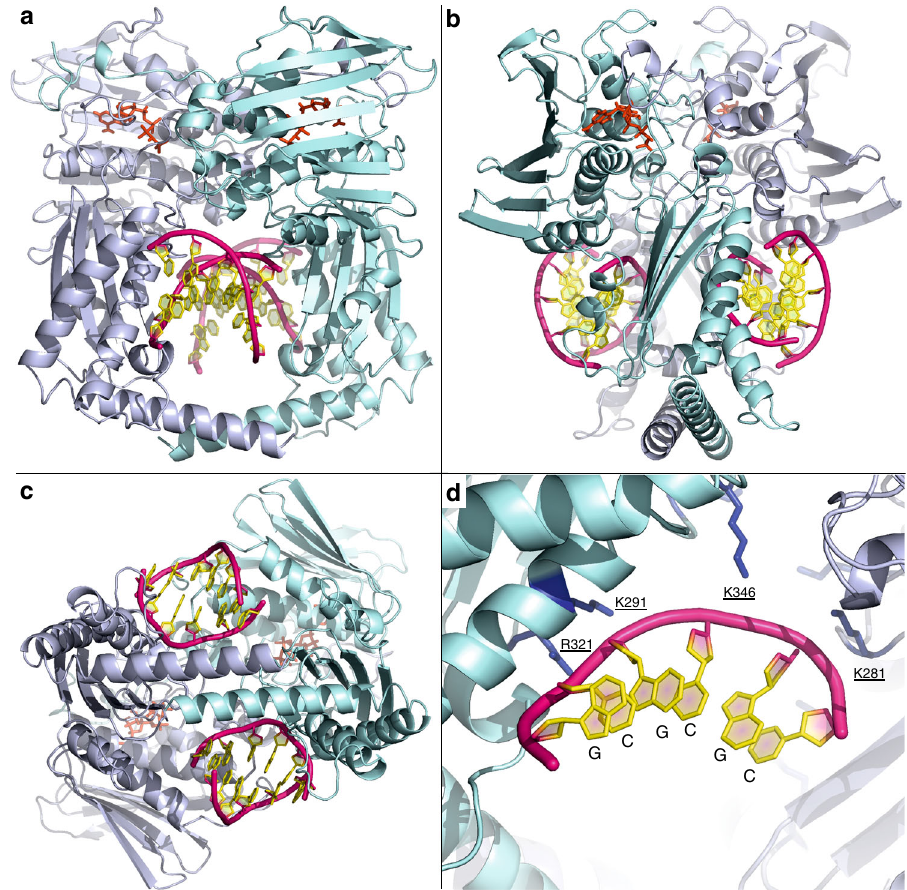
Fig. 3 X-ray crystal structure of ParE44 with side-bound 5 ′ -GCGCGC-3 ′ duplex DNA and AMP-PNP. a , b , c Front, side and bottom views of the complex and d residues that interact with the DNA and were targeted for mutagenesis (underscored). The ParE44 protein forms a closed dimer with two molecules of DNA bound as a regular B-form helix but on the outside of the protein rather than in the hole. N-terminal ParE domains are shown in cartoon mode in light blue and cyan, bound AMP-PNP molecules are in red and DNA is in mauve/yellow for backbone/bases,